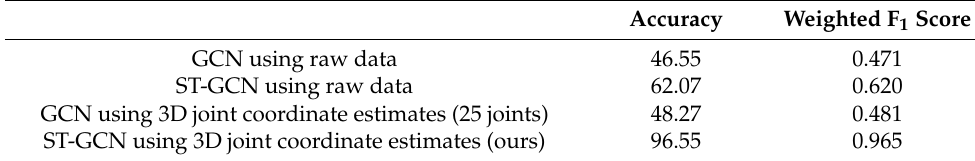
Table 5. Performance comparison with different features on the MMActivity dataset